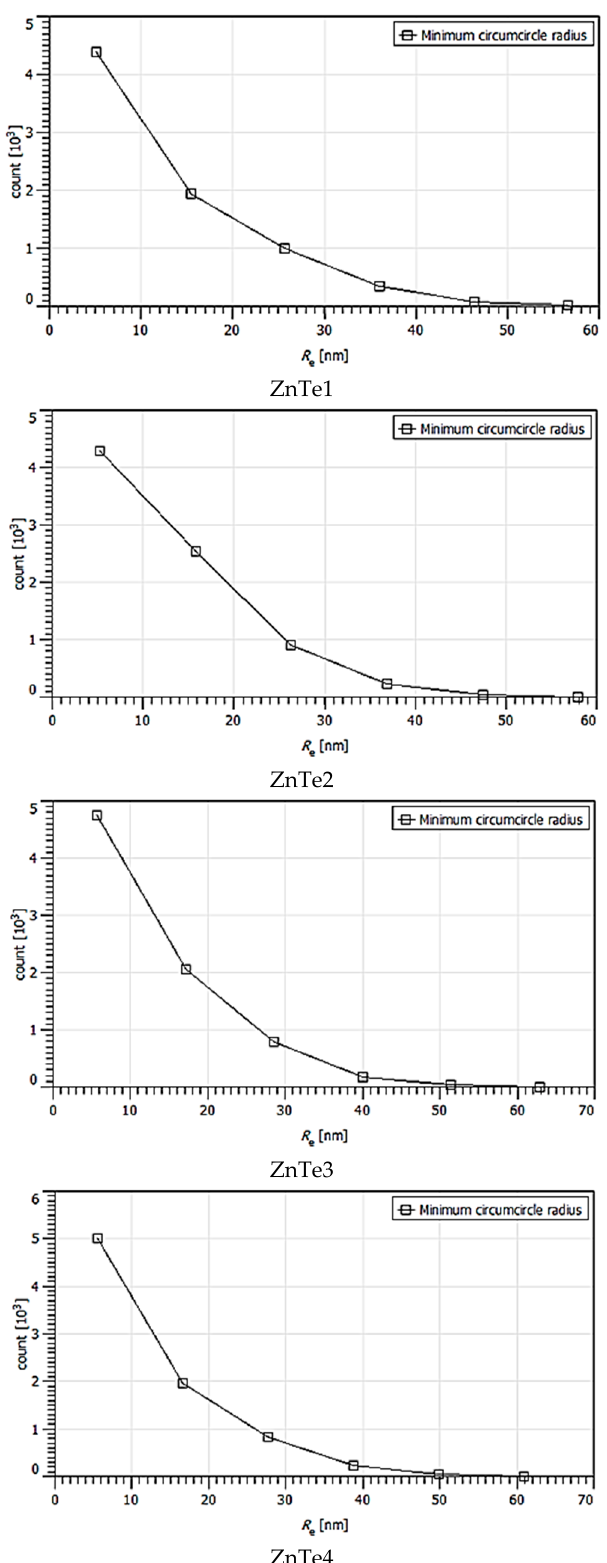
Figure 4. Minimum circumcircle radius value statistic variations onto surfaces of ZnTe1,2,3,4 thin films, presented in AFM images.